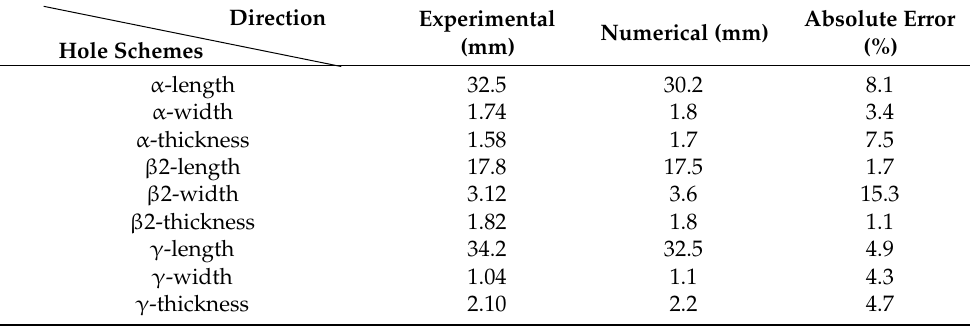
Table 5. Comparison of numerical and experimental dimensions.